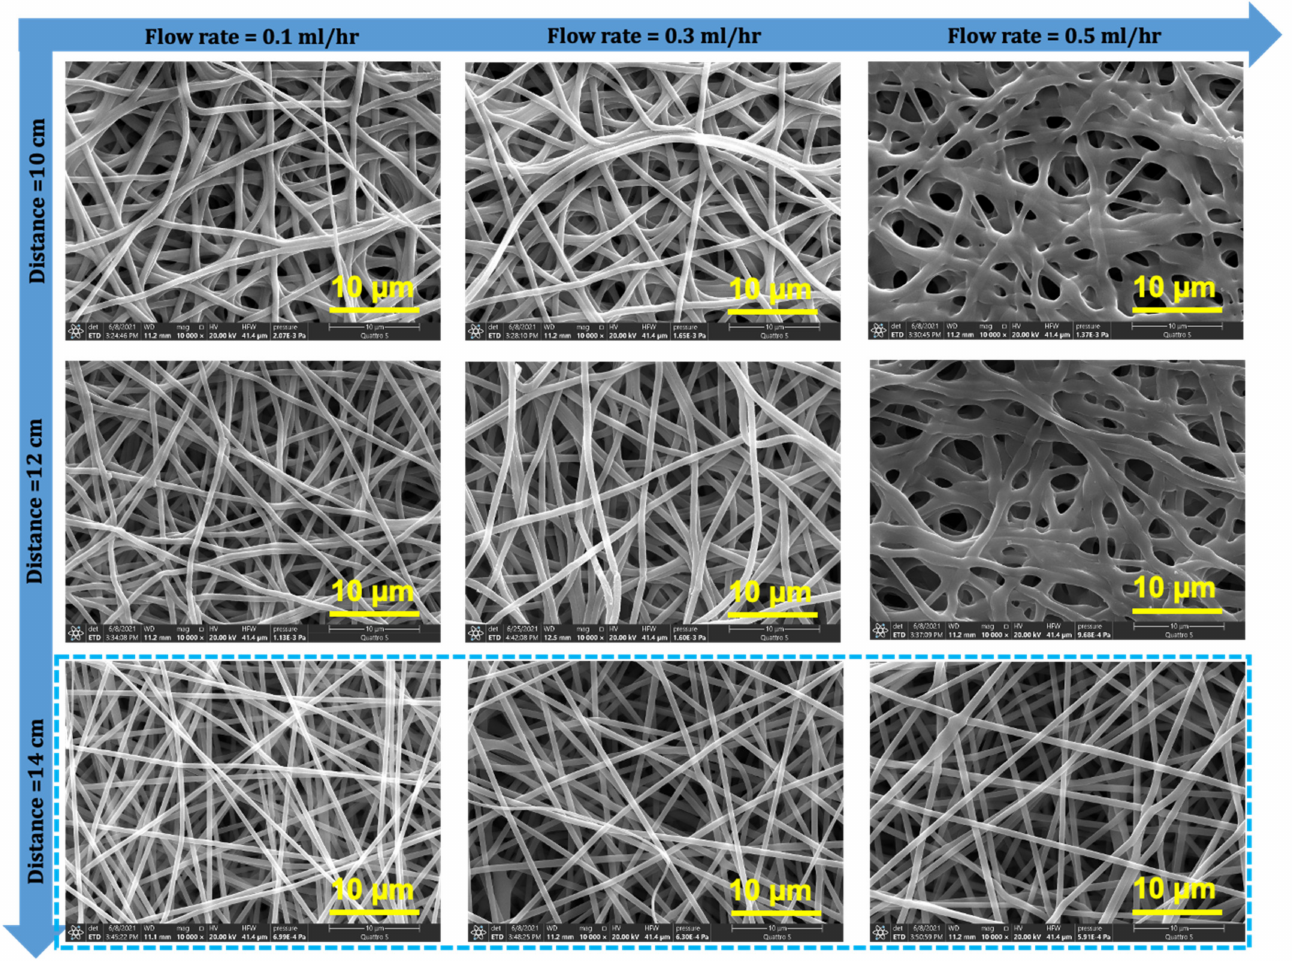
Figure 5. FE-SEM images of 27EVOH_22% at different flow rates and distances used to optimize and study the effect of the electrospinning condition on nanofiber